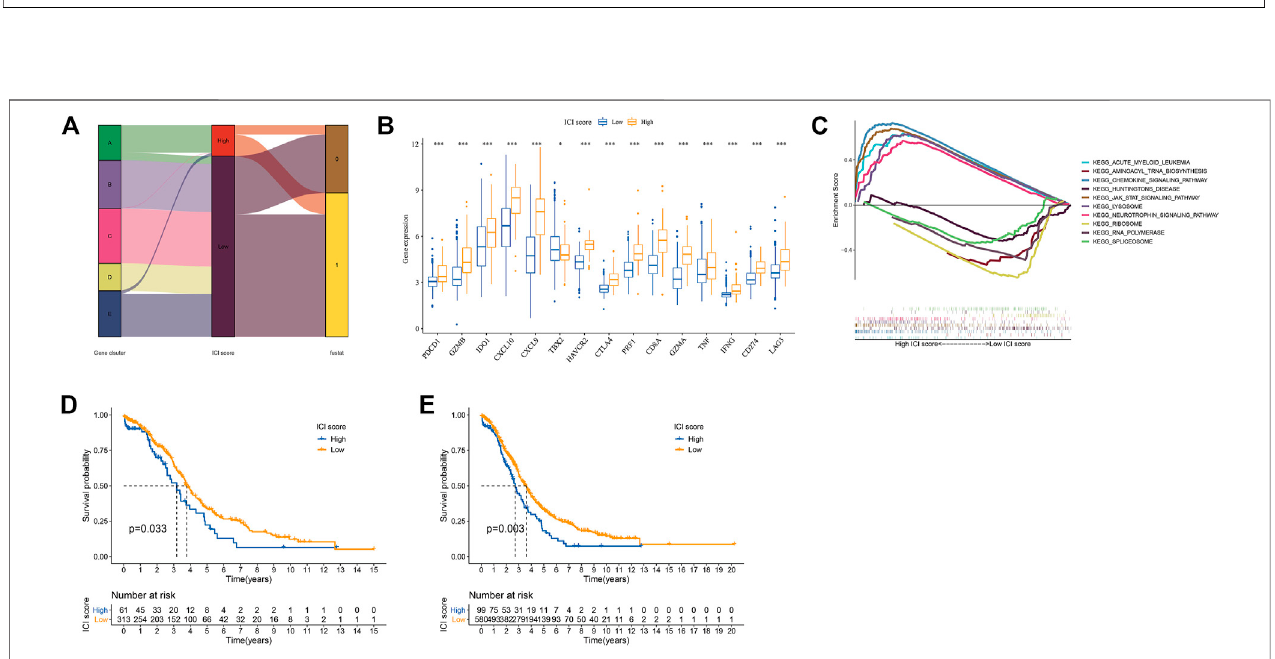
FIGURE 4 | Construction of ICI scores model. (A) Alluvial plots of the distribution of ICI gene clusters in different ICI clusters, ICI scores and survival outcome groups. (B) The expression of the Immune related genes (* p < 0.05; *** p < 0.001). (C) GSEA enrichment analysis (only the top fi ve are shown). (D) Kaplan-Meier curve (TCGA-OC). (E) Kaplan-Meier curves (GSE18520, GSE26193, GSE19829, GSE30161, GSE63885, and TCGA-OV).